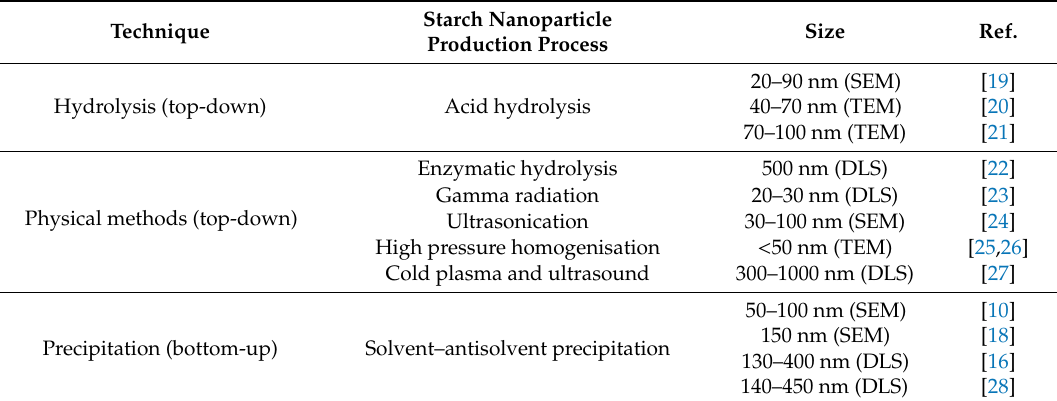
Table 1. Methods of starch nanoparticle